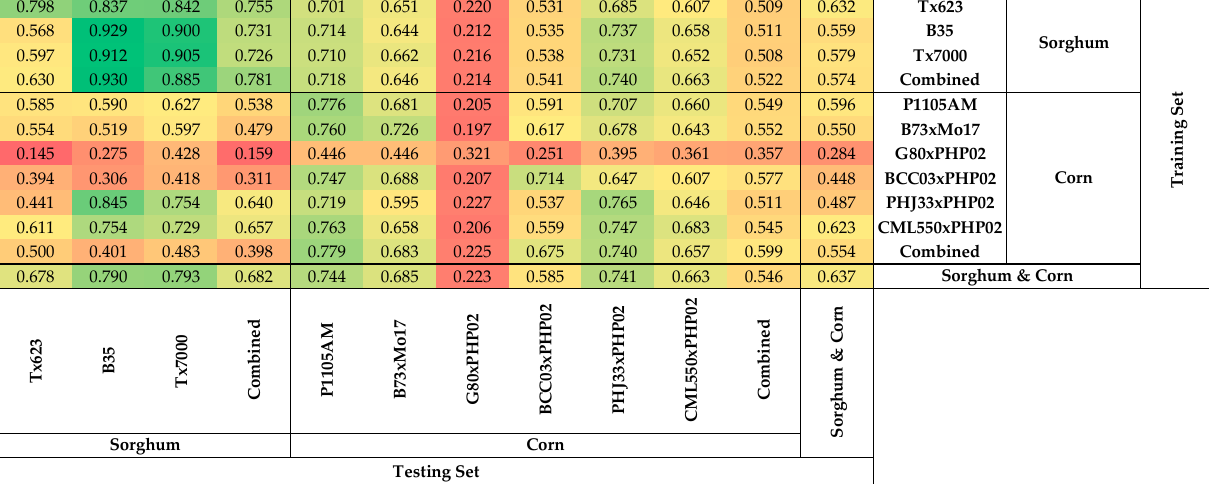
Figure 5. Heatmap of coefficients of determination of models predicting nitrogen content of different genotypes with hyperspectral reflectance.